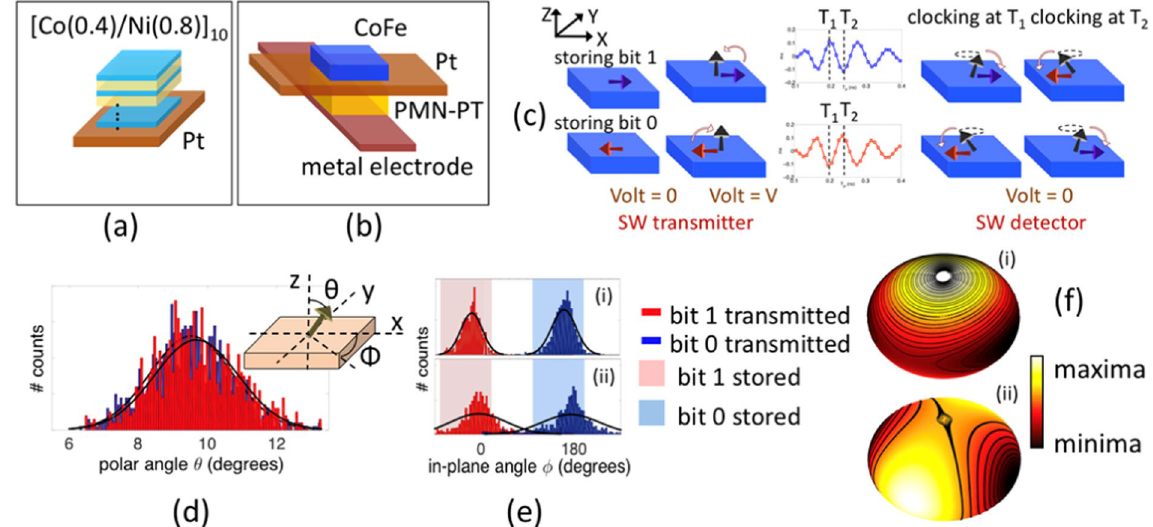
Figure 1. Basic building blocks for a spin wave logic device - ( a ) PMA [Co(0.4)/Ni(0.8)] 10 multilayer spin wave bus and ( b ) ME cell comprising of a magnetostrictive Co 60 Fe 40 layer grown on (001)PMN-PT ferroelectric layer. ( c ) Working principle of the spin wave device, based on voltage-controlled strain-mediated magnetization switching, ( d , e ) Gaussian distribution of the amplitude ( θ = cos − 1 mz) and phase ( φ = tan − 1 (m y /m x )) of the arriving spin wave, detected at the falling edge of the clock, ( f ) energy landscape and magnetization relaxation trajectory from out-of-plane to in-plane energy minima for the case of (i) a nanomagnet with in-plane stable magnetization states, and (ii) lowered out-of-plane energy barrier resulting in the interchange of the position of the saddle point and the energy